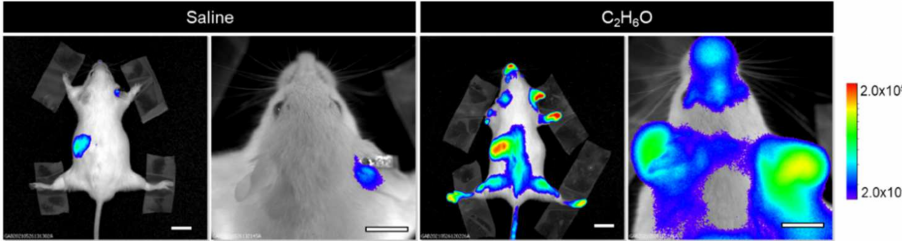
Figure 6. NF-Y-dependent luciferase activity in the MITO-Luc mouse model in response to acute ethanol administration. In vivo longitudinal bioluminescence imaging analysis of a representative animal 6 h after either saline or ethanol administration. The pseudo-color scale bar represents the relative bioluminescent signal intensities from the lowest (blue) to the highest (red); radiance is expressed in photons per second per square centimeter per steradian (photons/s/cm 2